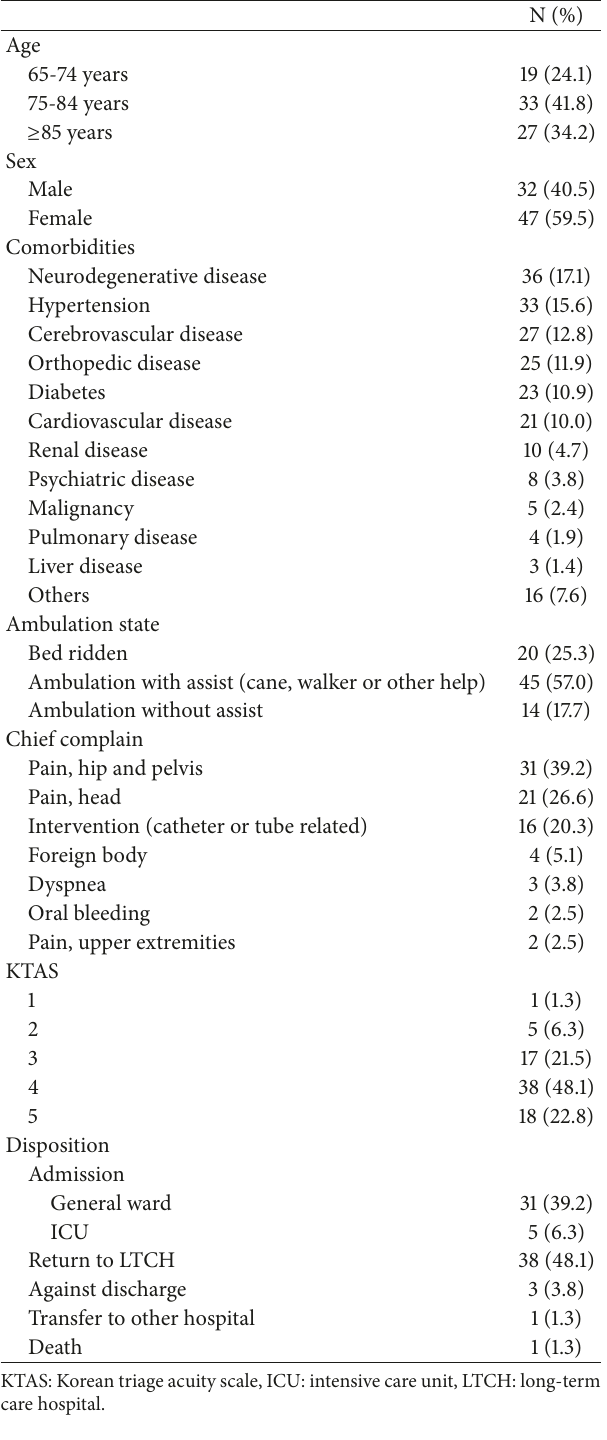
Table 1: General characteristics of patients aged ≥ 65 years with nonmedical cause transferred from long-term care